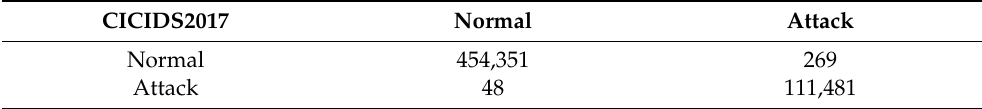
Table A2. Layer 1 confusion matrix for CICIDS2017